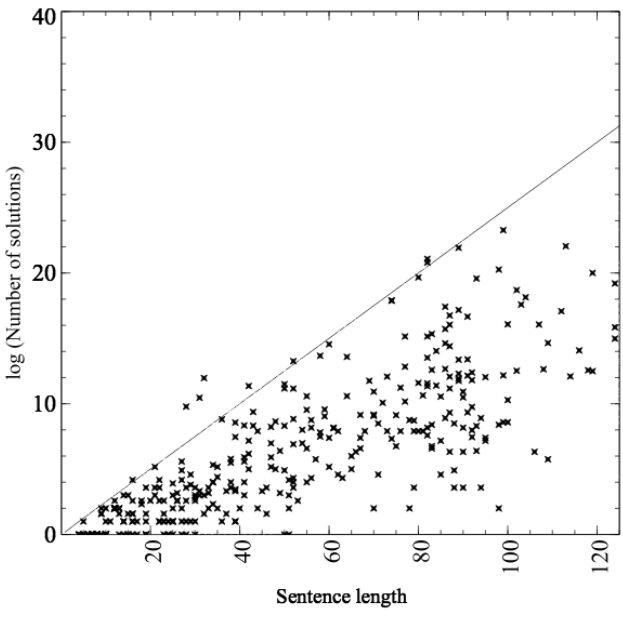
Figure 10: Scatter plot showing the distribution of the number of solutions (log) with respect to the length of the